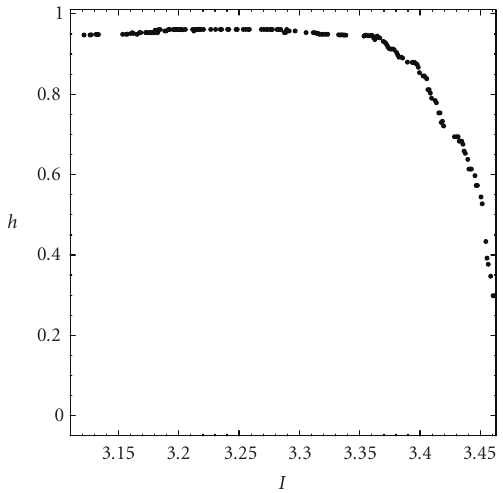
Figure 2.23. Variation of the topological entropy for I ∈ [3 . 12, 3 . 462], r = 0 . 005, and s = 4 . 0.